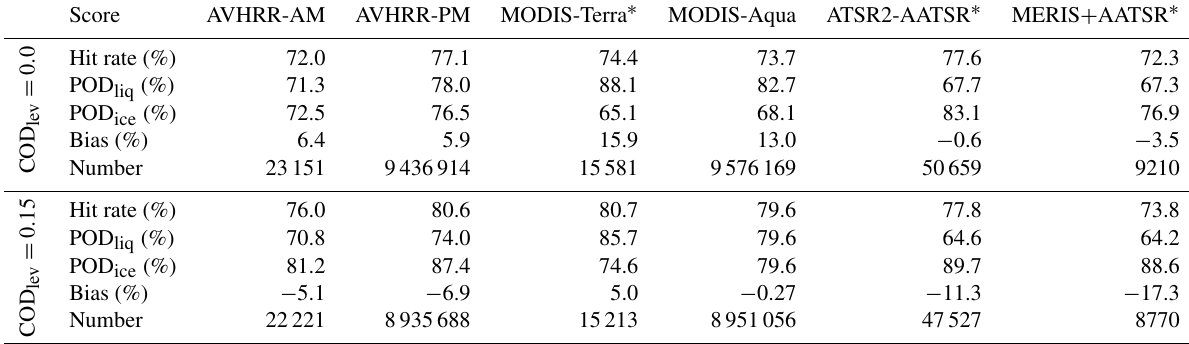
Table 7. Summary of cloud phase (CPH) validation results for Cloud_cci datasets when compared against CALIOP. Validation measures are probability of detection (POD) and bias of liquid cloud occurrence. Also given is the number of collocated pixels. The scores are separated into two cloud optical depth levels (COD lev ) representing at which top-down COD into the cloud the reference CALIOP CPH was taken.